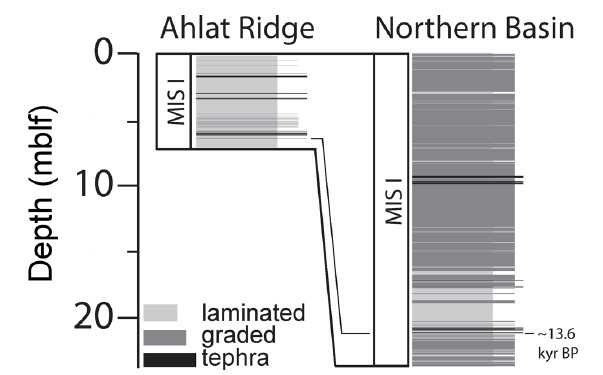
FIGURE 4 | Sedimentation at Northern Basin site andAhlat Ridge site during the Marine Isotope Stage I (MIS I) including volcaniclastics, event deposits and lacustrine (laminated) sedimentation at NB andAR sites. Especially sediments at the NB site are influenced by large amounts of graded event deposits and volcaniclastic deposits